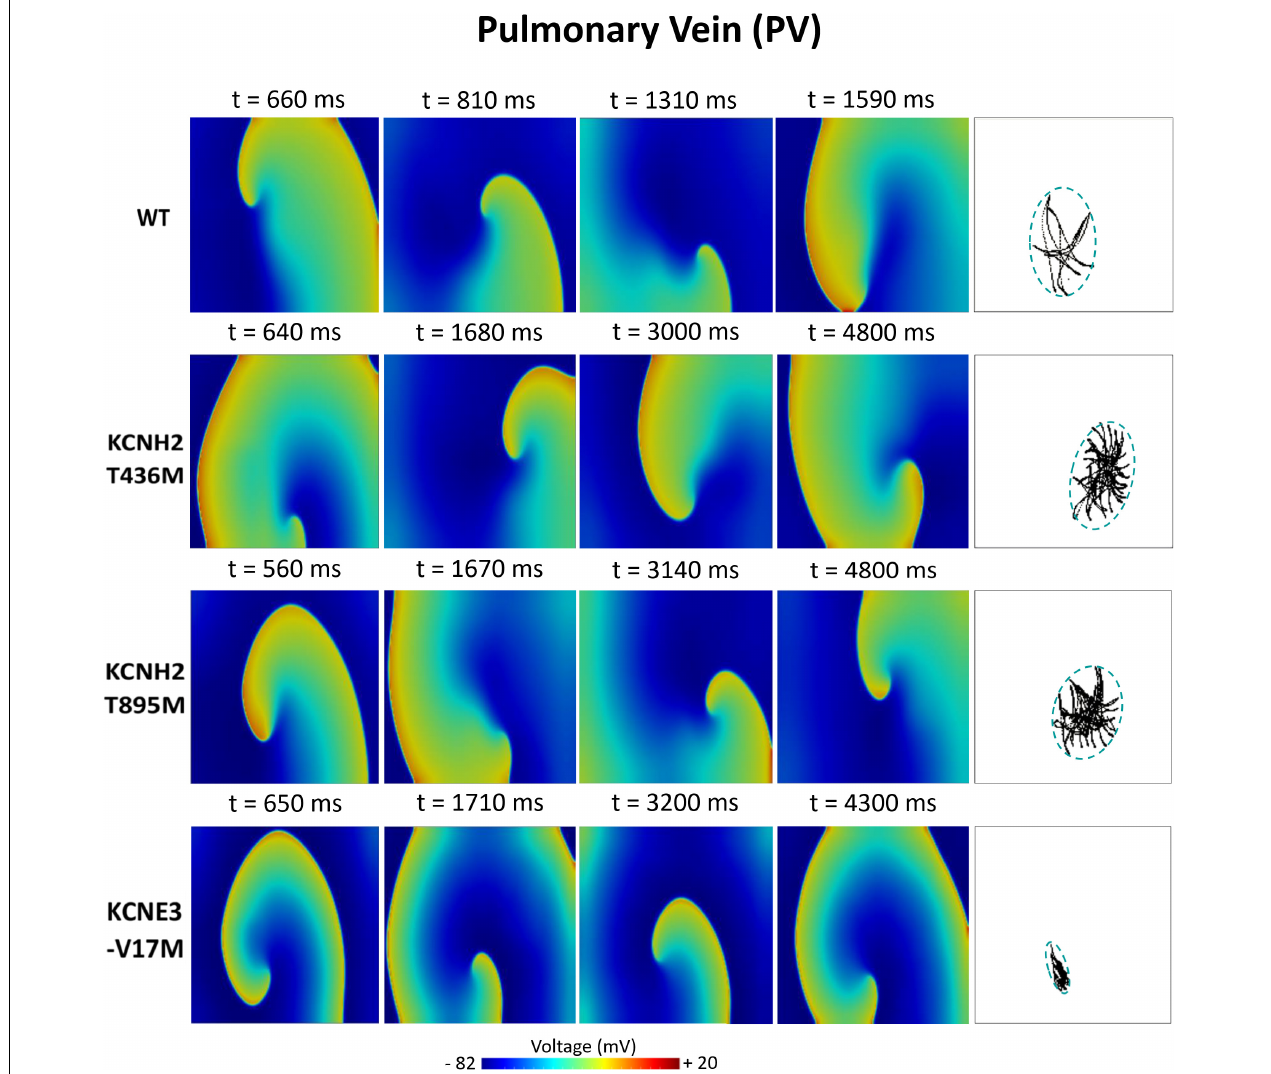
FIGURE 8 | Simulation of spiral waves in 2D pulmonary in control (WT) and affected by KCNH2 T436M, KCNH2 T895M, and KCNE3-V17M mutations. Color-coded voltage snapshots of the rotors and rotors’ tip trajectory enclosed by an ellipse for the quantification of the meandering rotor’s area. S1–S2 interval for WT model was 205